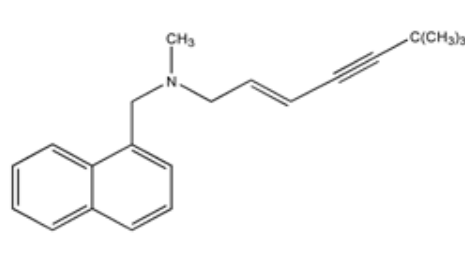
FIGURE 9. Terbinafine